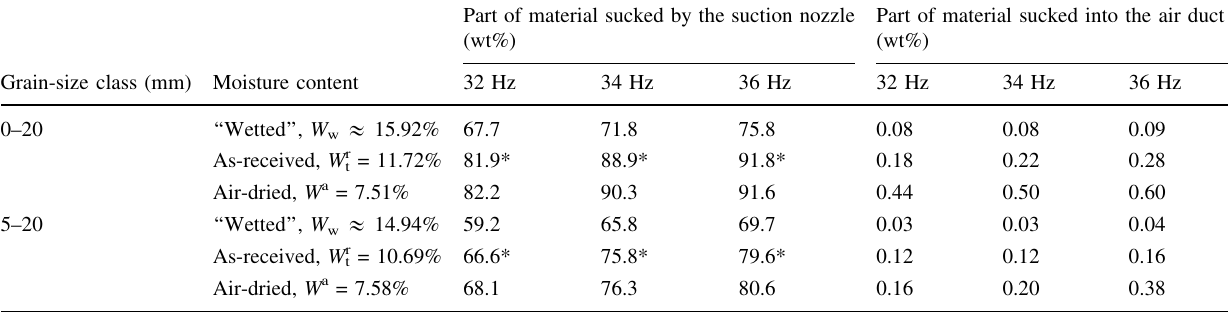
*Data based on the results of the main experiments